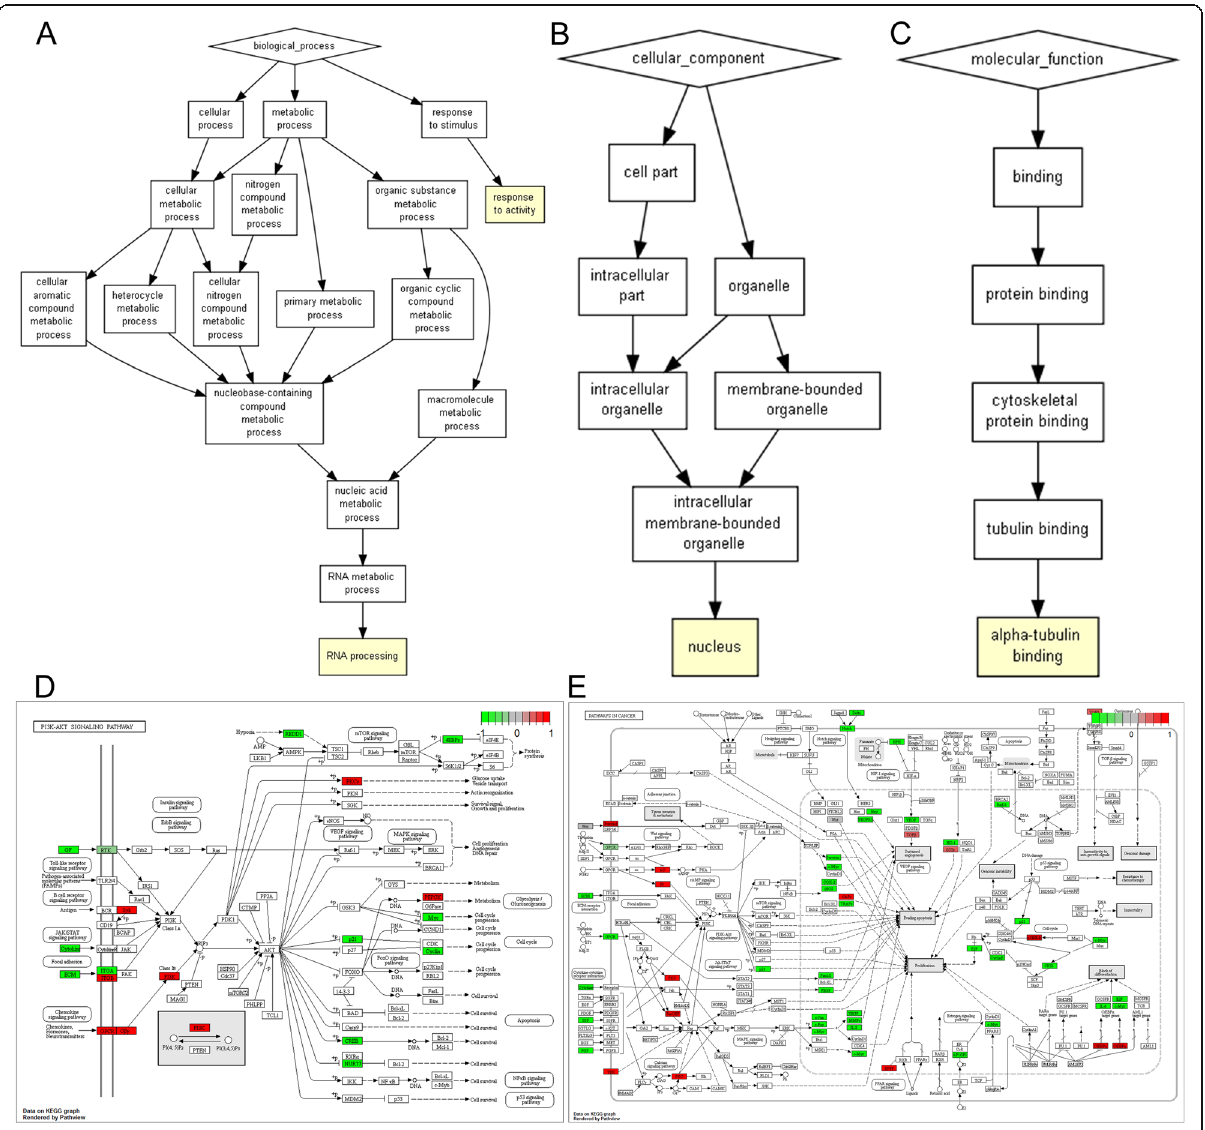
Fig. 5 Significantly enriched GO terms and KEGG pathways of DEmiRNA-target DEmRNAs. a . BP, biological process; b . CC, cellular component; c . MF, molecular function. d-e KEGG pathways. d . PI3K-Akt signaling pathway. e . Pathways in cancer. The red and green rectangles represented the particles which regulated by the up- and down-regulated target DEmRNAs of DEmiRNAs, respectively. Appropriate copyright permission to use the signalling pathways was